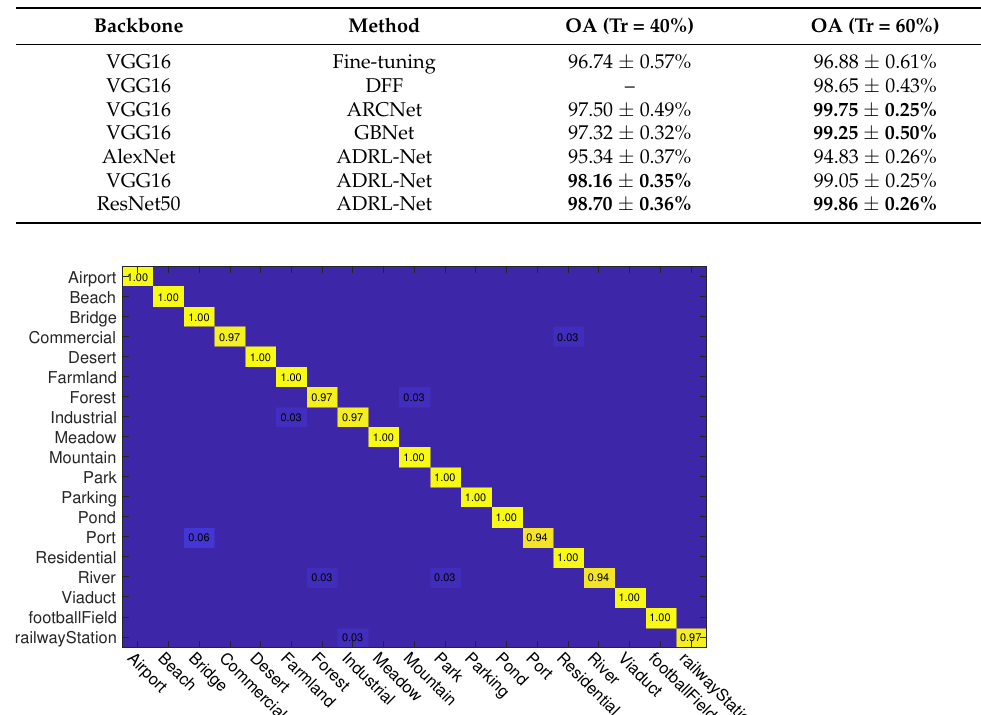
Figure 9. Confusion matrices obtained by ADRL-Net with ResNet50 as backbone on NWPU dataset (Picture can be enlarged by scaling the document). Tr = 20%. Table 4. OA comparison of different methods on WHU-RS19 dataset. The best two results are highlighted in bold font.